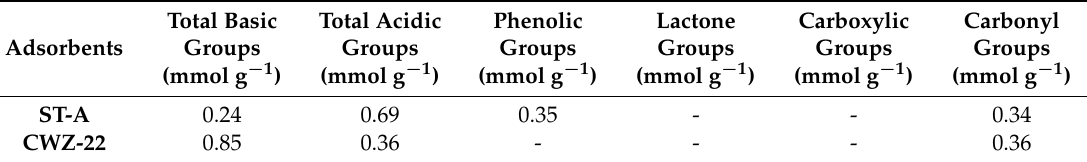
Table 3. Functional groups available on studied